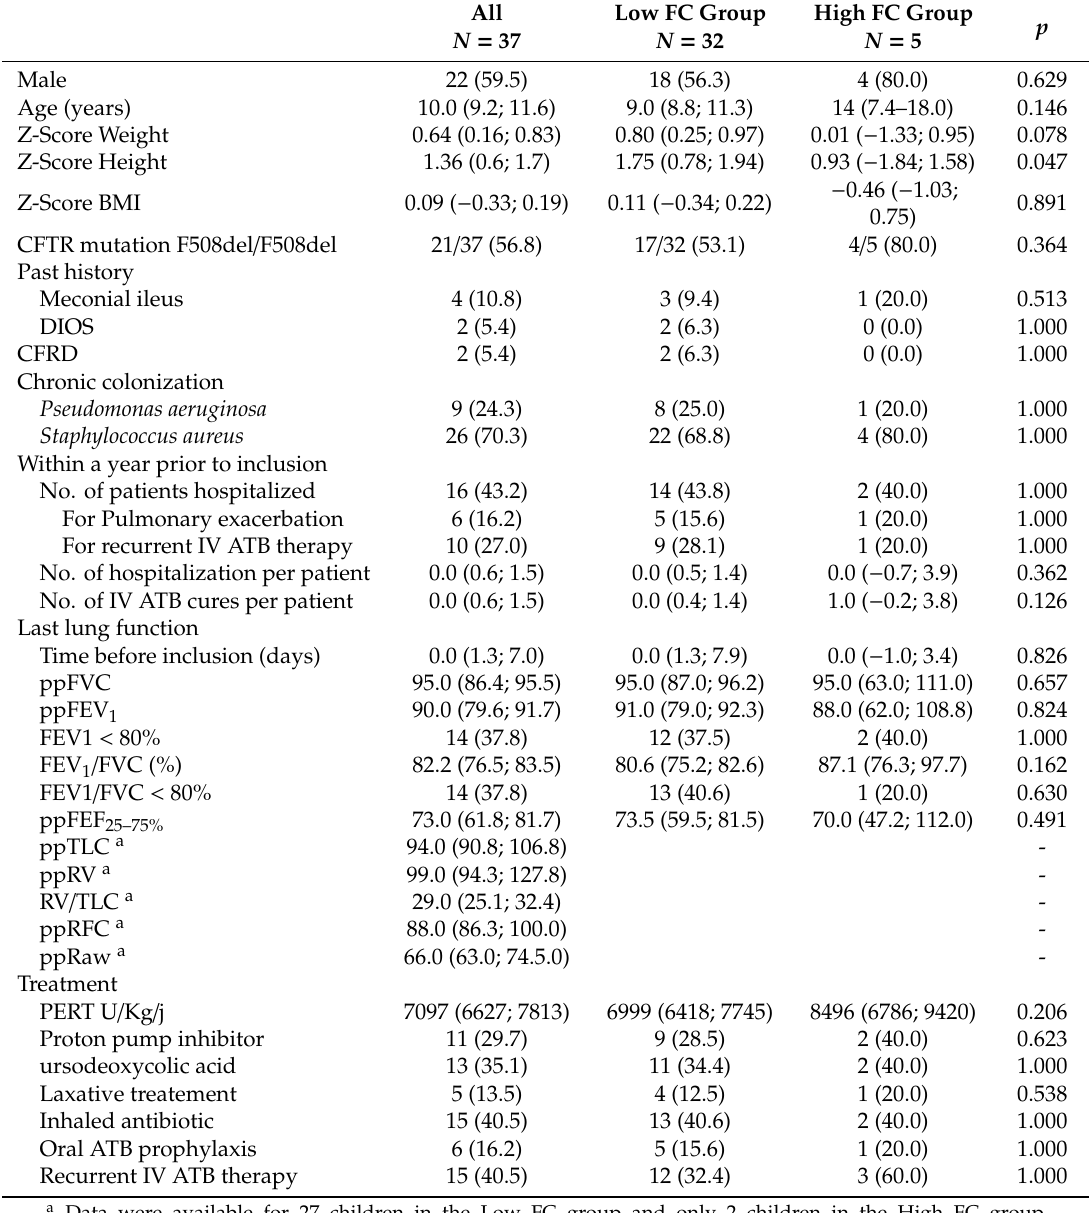
Table 1. Population’s